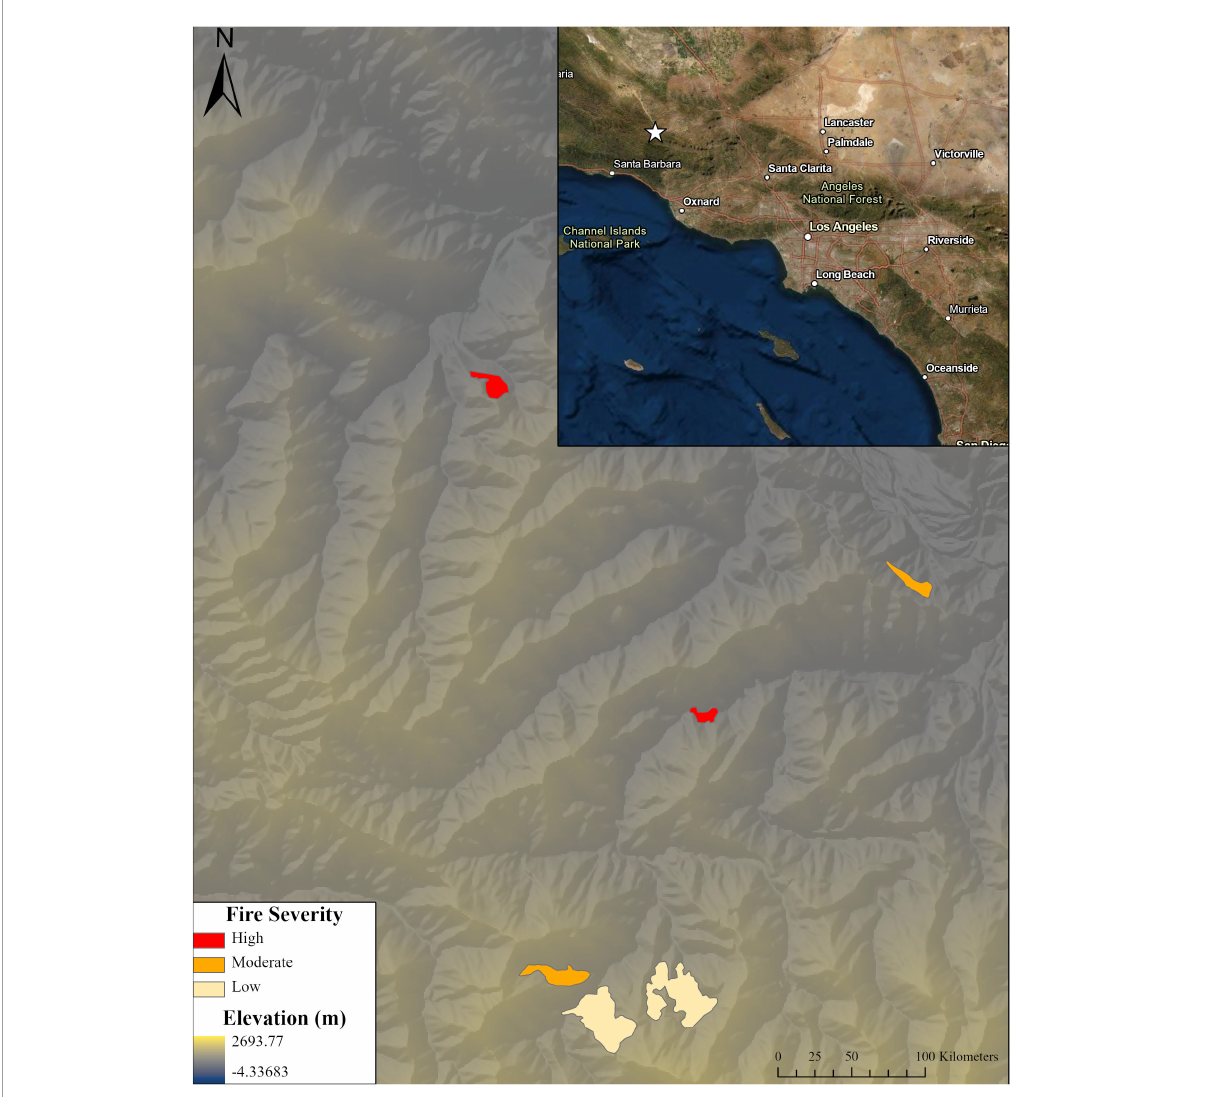
FIGURE1 Map of study locations. Planting areas were chosen to be as close to one another as possible to constrain climate, elevation, and parent material. They follow CA HWY 33 on the north side of the Pine Mountain saddle (34.649917, –119.385418). Sites are colored by the severity of fire experienced in the area, calculated from percent die-off (see above). Shading represents elevation and is overlaid on a hillshade layer to display topography. Shapefiles are available in the Supplementary material . Inset map shows the location of sites (white star) within a broader geographic